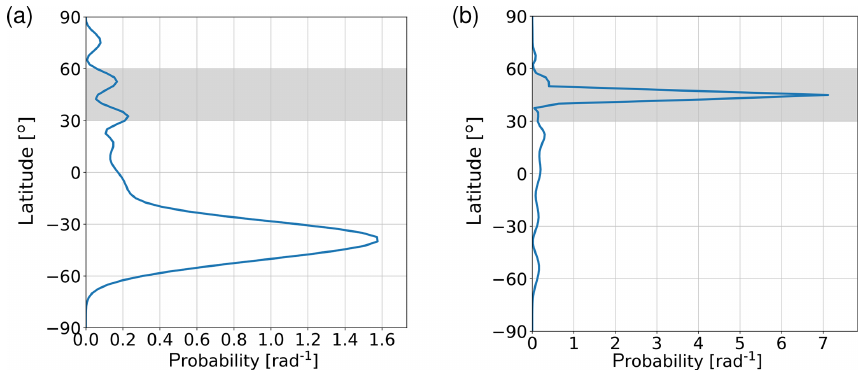
Figure 5. Probability density function P(φ) as defined in Eq. (34) for two different background flows: (a) solid-body rotation and (b) a strong narrow jet with U J = 40ms − 1 . The grey shading indicates the northern midlatitudes, where the forcing is located. Broadly speaking, the function P(φ) quantifies where the “wavines” can be found far downstream of the Rossby wave